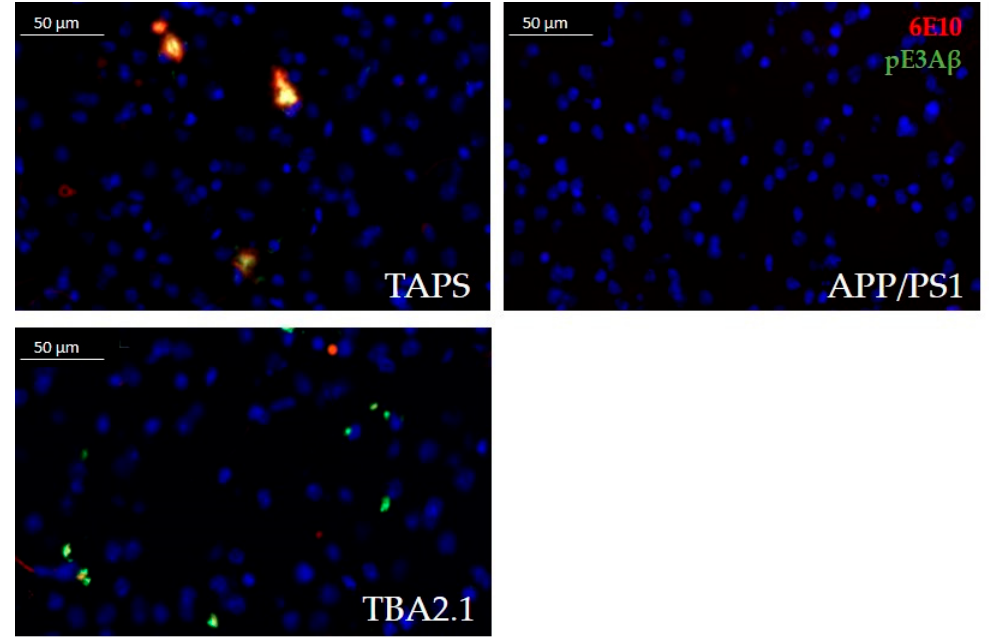
Figure 2. Comparison of A β accumulation in the lateral striatum at 400 × magnification. TAPS mice accumulated A β aggregates in the lateral striatum, positive for total A β (red, 6E10) and pE3A β (green, pE3). In TBA2.1 mice, A β deposits were smaller but also positive for total A β and intensively stained for pE3A β . APP/PS1 mice in contrast were lacking any A β accumulation in this area, showing only cell nuclei, positive for DAPI (blue). Images of representative animals are shown; for total animal numbers, see Table 1.